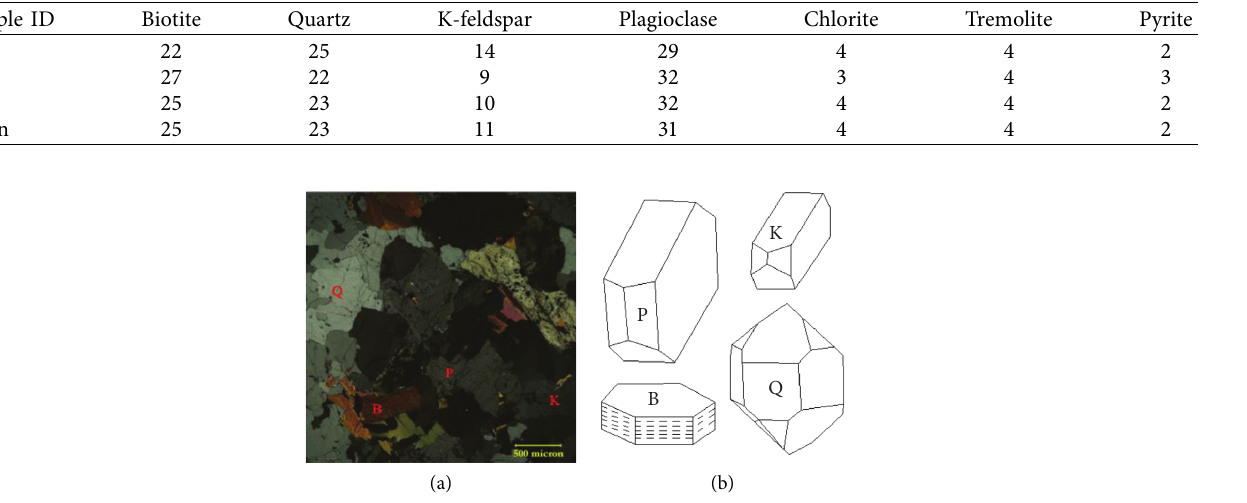
Figure 1: Testing facilities. (a) Nikon LV100POL polarizing microscope. (b) Hitachi S-3000N scanning electron microscope. (c) MTS815 rock mechanics testing machine. Table 1: Mineralogical composition of the tested material (weight %).